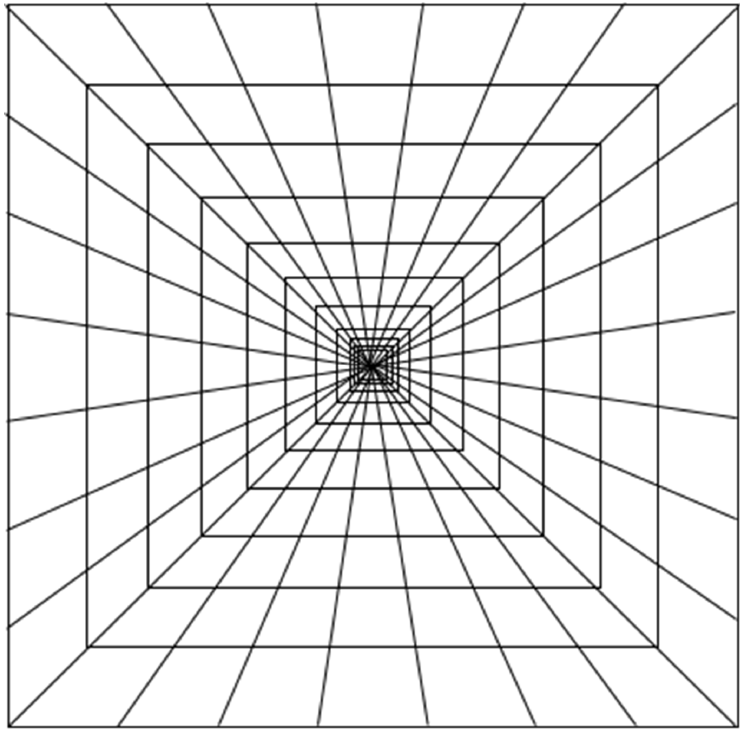
Figure 1. Schematic of experimental stimulus 1 (CP): COMPLETE (obliques + squares) HUGHES-TYPE “PERSPECTIVE” GRID.